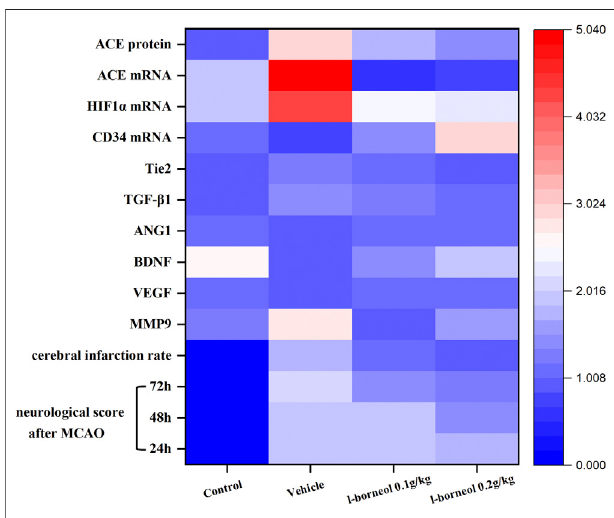
FIGURE 10 | Heat map results of l- borneol on various indicators.